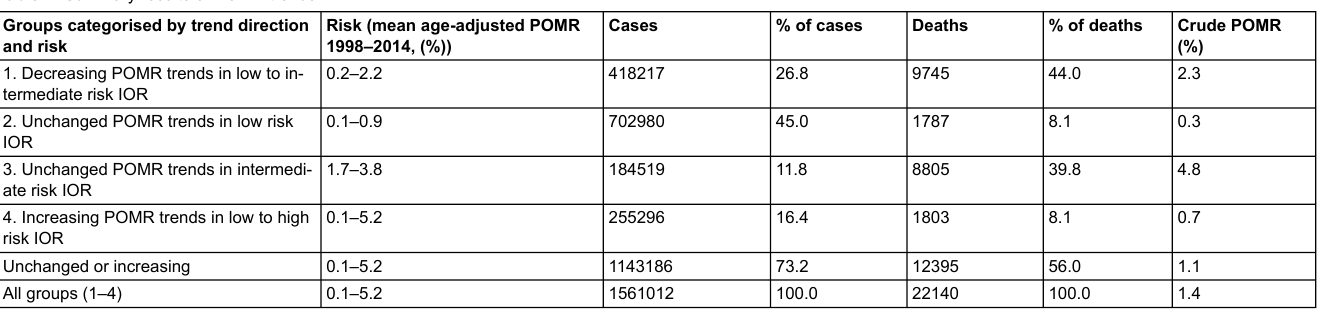
Table 2: Summary results of POMR trends. Groups categorised by trend direction and